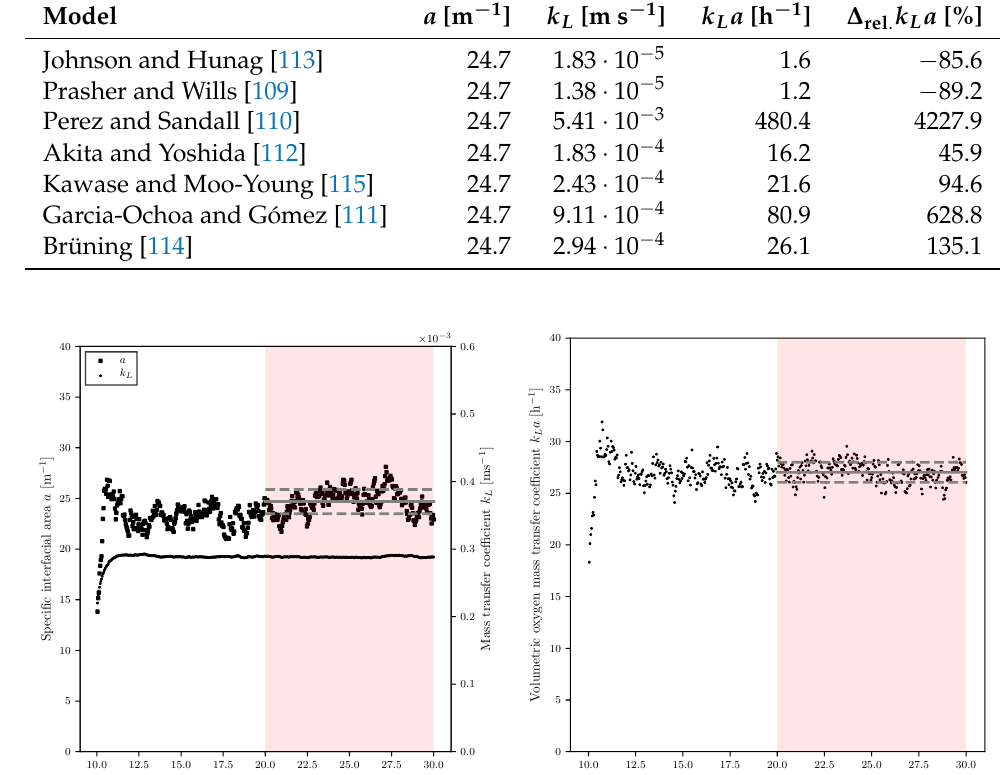
Table 4. Overview of different mass transfer coefficient models and their effect on the k L a calculation for the base simulation. The relative k L a difference refers to the experimentally measured k L a value of 11.1h − 1 .